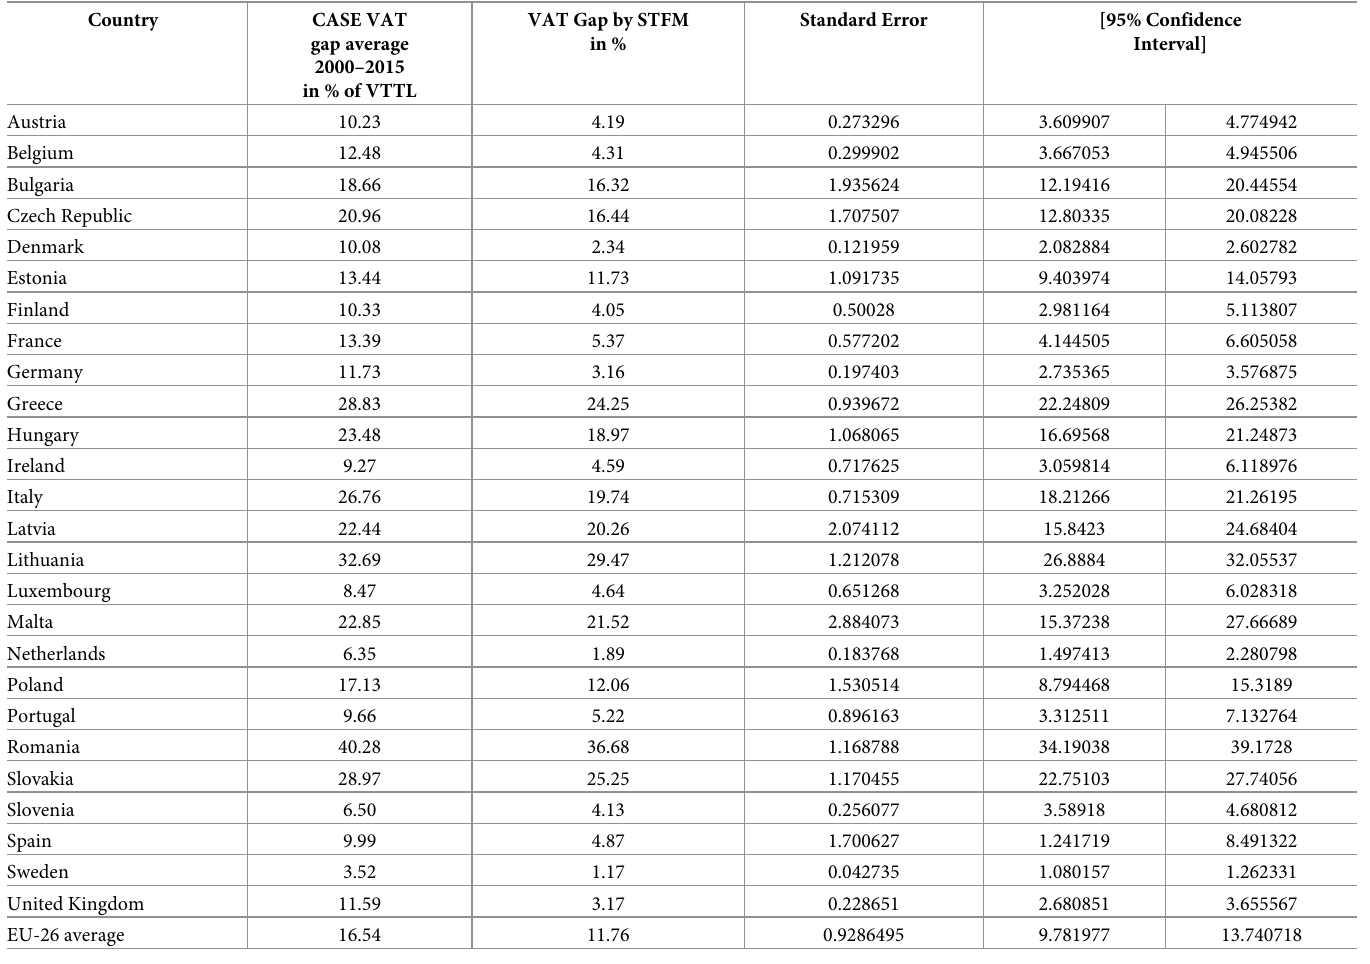
Table 4. Results from panel data STFM estimation of VAT gap using Battese and Coelli [7] model for EU-26 countries,